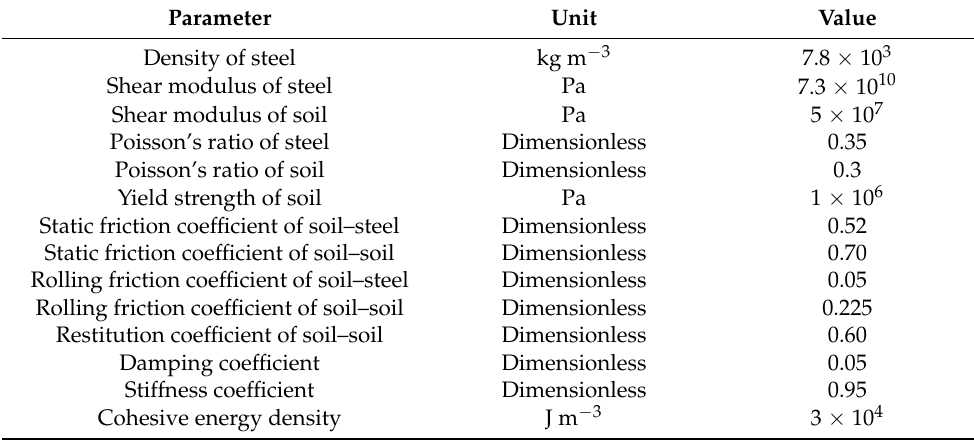
Figure 3. Measurement of soil rupture distance ratio: ( a ) Diagram showing soil rupture distance ( f ) and working depth ( d ); ( b ) Moment one when soil particles in the white line began to move; ( c ) Moment two when the tool arrives at the white line; ( d ) Measuring of soil disturbance area; ( e ) Measuring of soil surface flatness. (BST = bending subsoiling tool). Table 1. Major parameters for the discrete element